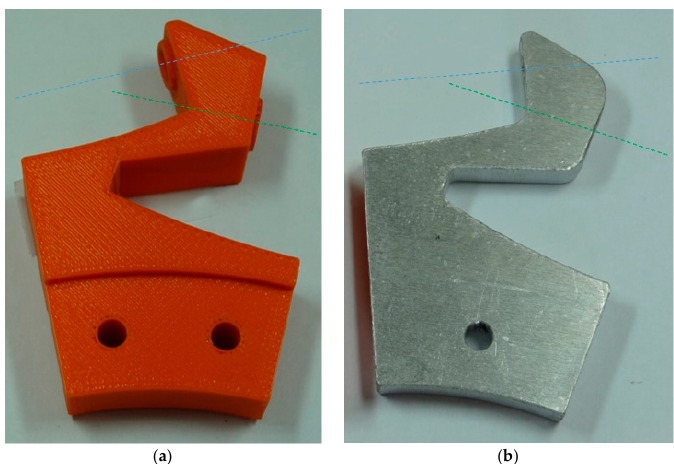
Figure 9. Rollers brackets with axis of big passive roller (green axis) and small passive roller (blue axis). ( a ) Example made of ABS plastic with a rapid prototyping 3D printer; ( b ) made of aluminum with laser cut and numeric control.